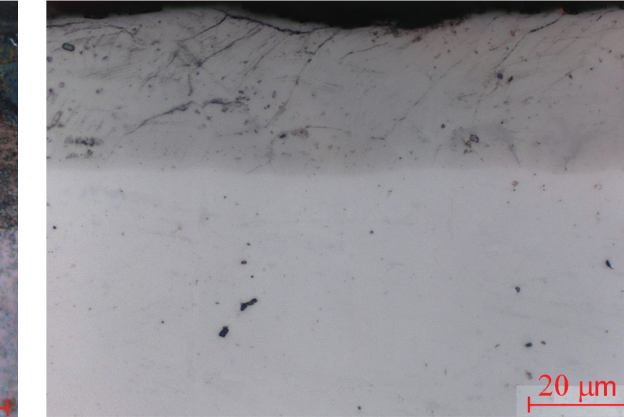
Figure 7: Cross-section of a nitrided sample, treatment time 60 min Nitriding temperature 565°C, sample bias – 750 V, sample current density 2.4 mA/cm 2 , layer microhardness 10.1